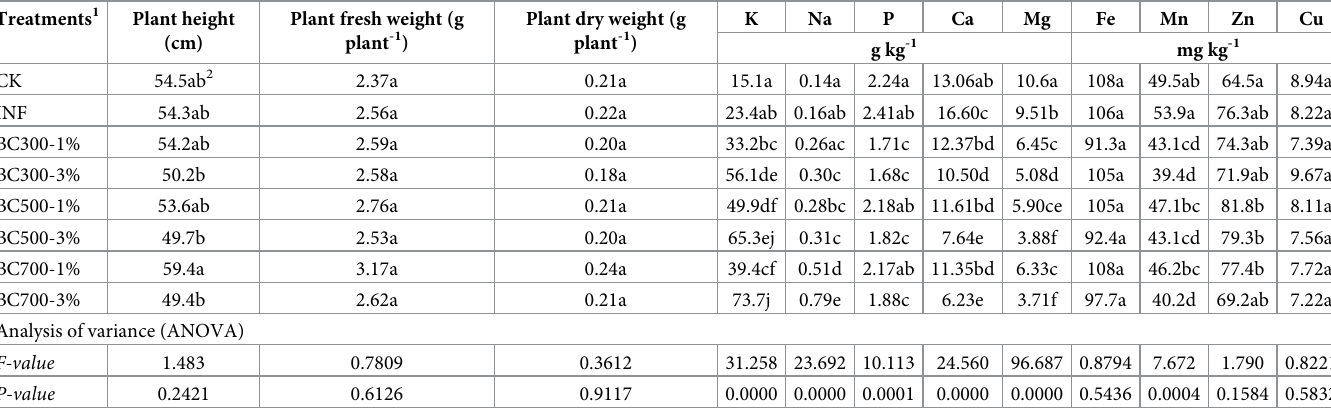
Table 5. Olive Mill Solid Waste-derived Biochar (OMSW-BCs) effects on plant height, fresh and dry matter, and shoot mineral content of Zea mays . Treatments 1 Plant height